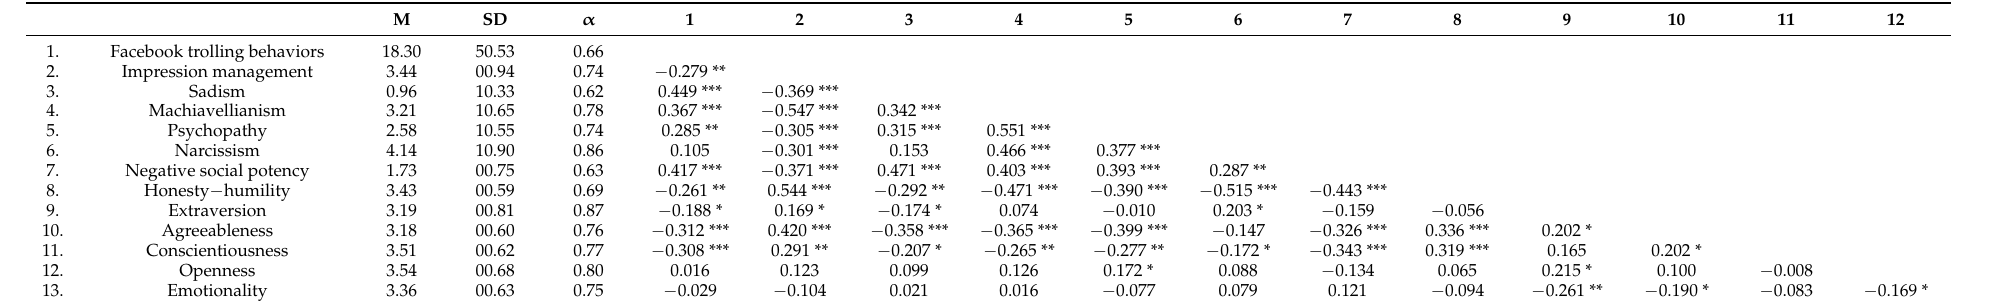
Table 1. Means, standard deviations, Cronbach’s alphas ( α ) and Pearson correlation coefficients for Facebook trolling behavior, impression management, Dark Tetrad traits, negative social potency and the HEXACO personality